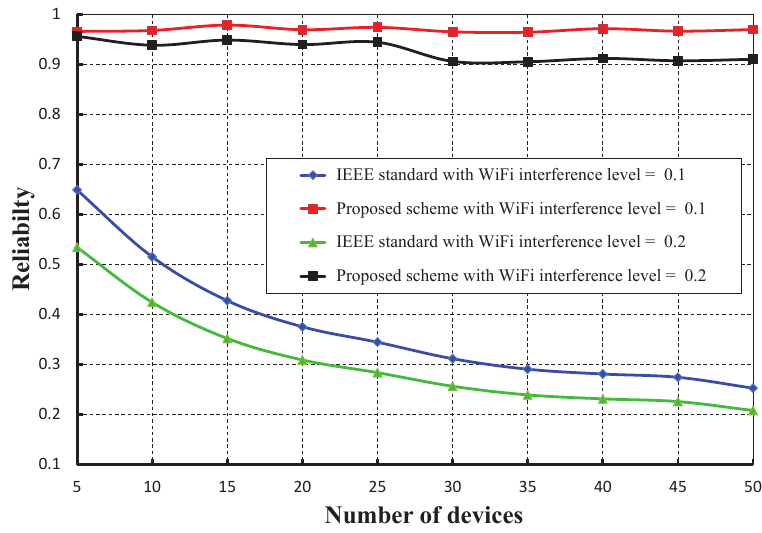
Figure 23. Comparison of the reliability of our proposed scheme with the IEEE 802.15.4e standard under different WiFi interference levels.